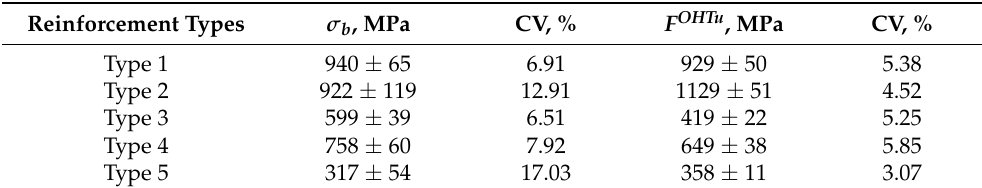
Table 2. Mean ultimate strength (ASTM D 3039) and ultimate stresses (ASTM D 5766) for carbon fiber specimens of the studied reinforcement